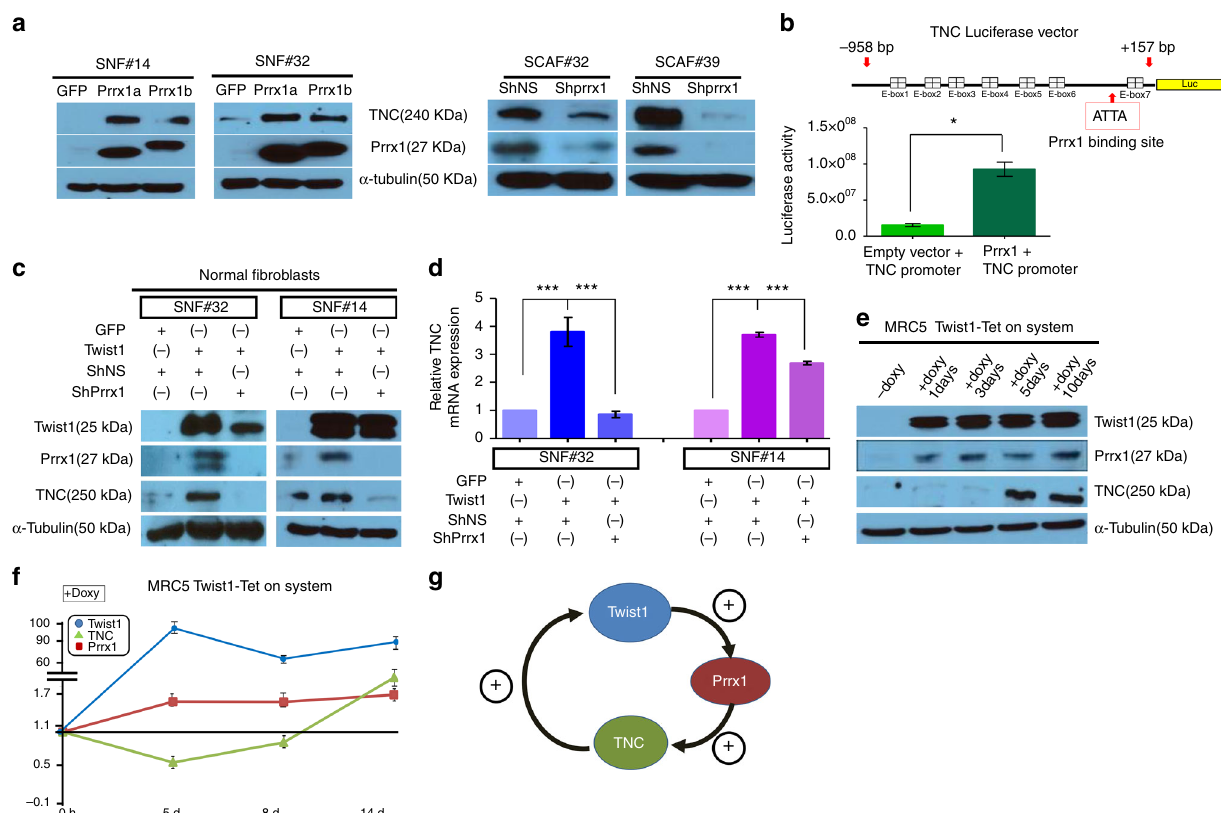
Fig. 3 Twist1, Prrx1, and TNC formed a positive feedback loop in fi broblasts. a , b Prrx1 directly upregulates TNC expression in fi broblasts. a Both Prrx1a and Prrx1b increased the TNC protein level in normal fi broblasts (SNF#14 and #32). Prrx1 depletion led to the downregulation of TNC expression in CAFs (SCAF#32 and #39). b Prrx1 enhanced the TNC promoter activity. Data are presented as the mean ± SEM; N = 3 independent experiments (two-tailed t test: * p <0.01). c , d Prrx1 is indispensable for Twist1-induced TNC expression at the protein ( c ) and mRNA ( d ) level. Data are presented as the mean